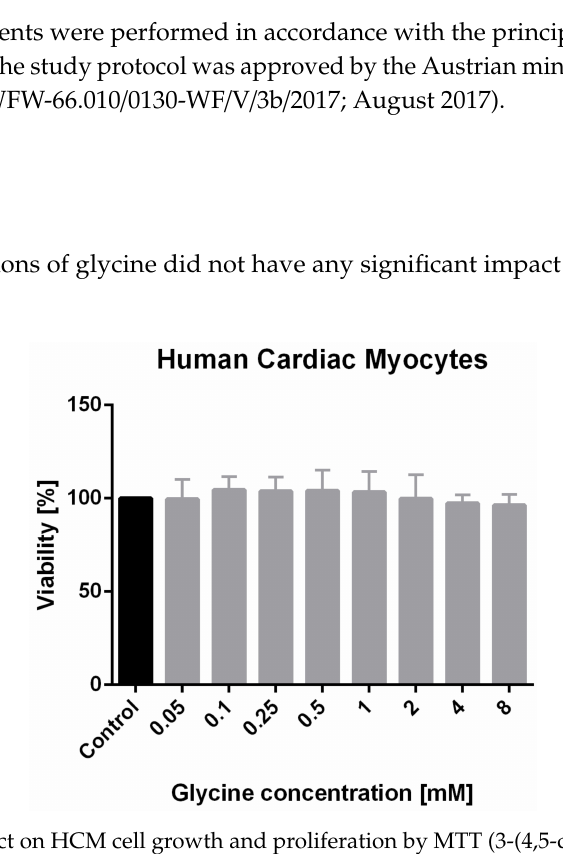
Figure 2. Glycine e ff ect on HCM cell growth and proliferation by MTT (3-(4,5-dimethylthiazol-2-yl)5- diphenyltetrazolium bromide) assay. HCM cells viability after incubation with various concentrations of glycine measured by MTT assay and presented as the percentage of the